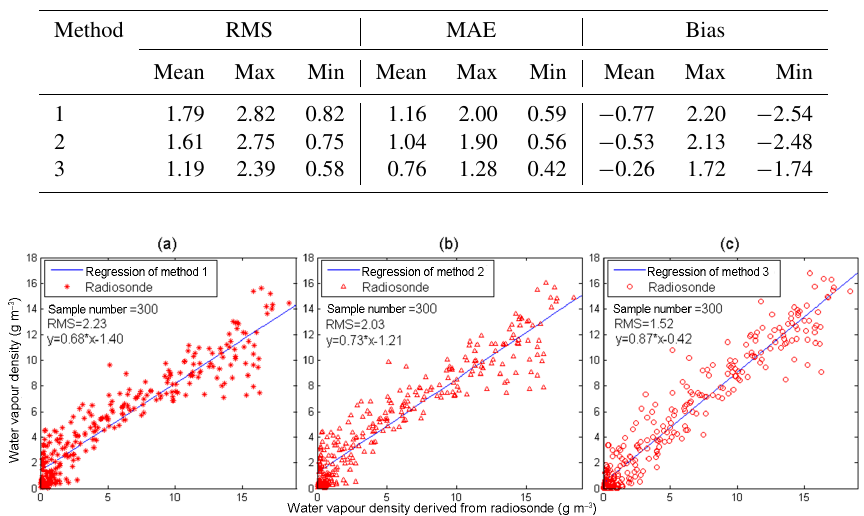
Figure 13. Linear regression of water vapour density derived from radiosonde and three tomography methods in the experiment.